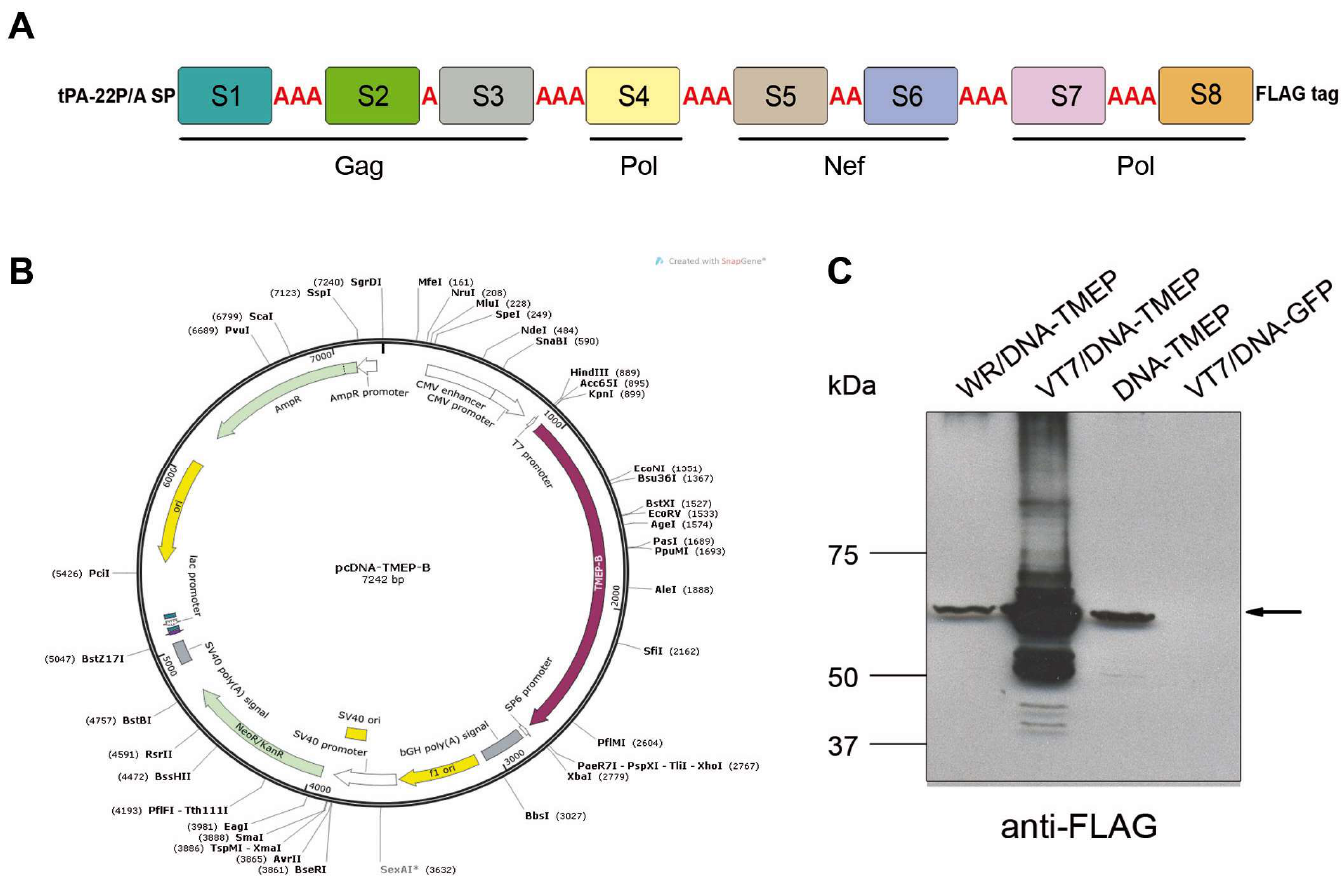
Figure 1. T cell multiepitopic B (TMEP-B) design, construction of pcDNA-TMEP-B plasmid, and TMEP-B expression analysis by Western blot. ( A ) Scheme of TMEP-B protein. ( B ) Map of the plasmid pcDNA-TMEP-B. ( C ) Expression of TMEP-B construct by Western blot. The 293T cells were mock-infected or infected with 5 pfu/cell of Western Reserve (WR) or vaccinia virus (VACV) that expresses the T7 RNA polymerase (VT7) viruses, and transfected 1 h later with 5 µ g of pcDNA-TMEP-B or pMax-GFP. At 6 h post-infection, cells were harvested and lysed in Laemmli buffer with mercapoethanol and cell extracts were fractionated by 8% SDS-PAGE and analyzed by Western blot using mouse monoclonal anti-FLAG M2 antibody to evaluate TMEP-B